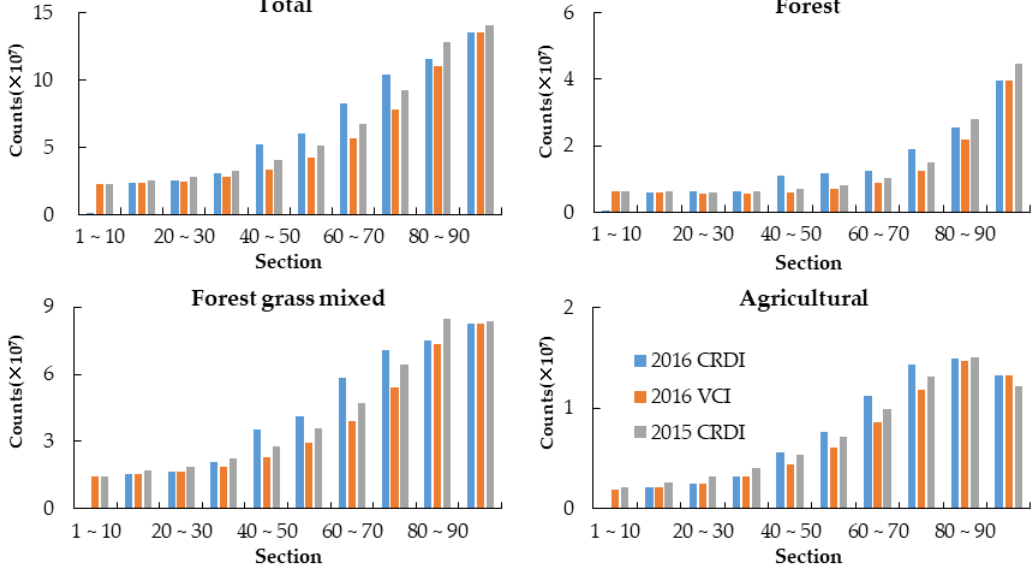
Figure 7. Comparison of histogram distribution of current CRDI, original VCI and previous CRDI.